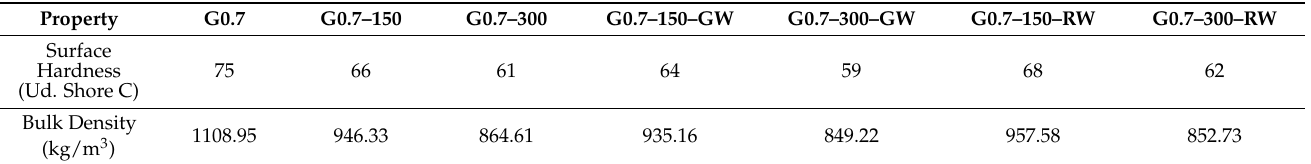
Table 5. Shore C surface hardness and bulk